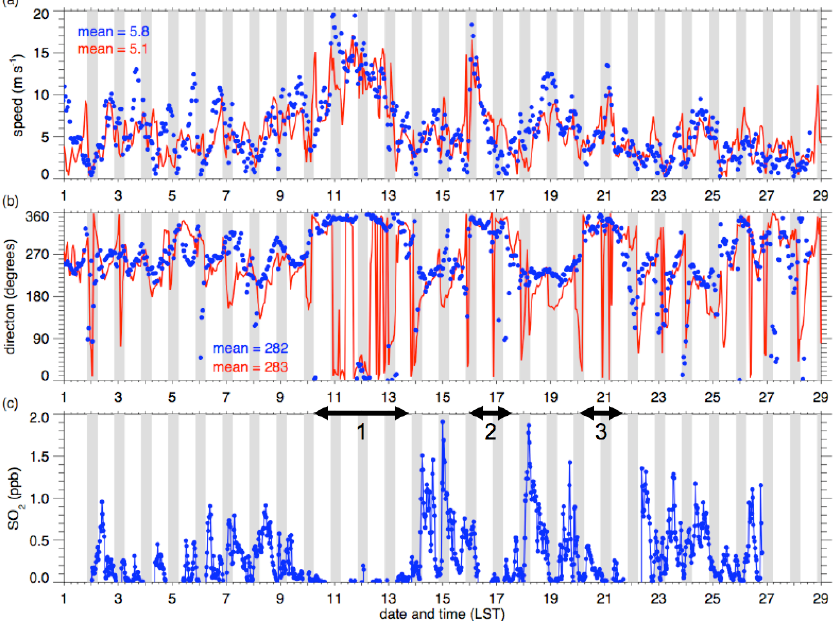
Figure 4. Observed (a) wind speed and (b) direction at the 563 m AGL range gate from the Sacramento radar wind profiler (blue dots) along with the simulated winds from the operational WRF forecasts at the same level (red lines). Observed (c) SO 2 measured at the T0 site. Gray shading denotes nighttime periods and arrows denote three periods of northwesterly synoptic flow associated with the passage of troughs over California.